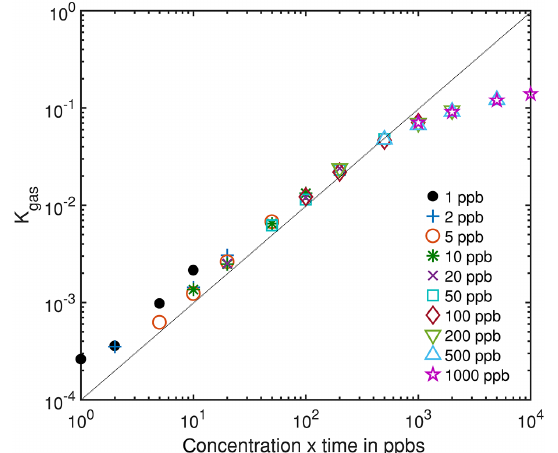
Figure 7. Integrated rate constant dependent on the gas dosage, i.e., the product of pulse concentration and duration, which is pro- portional to the amount of substance for different gas